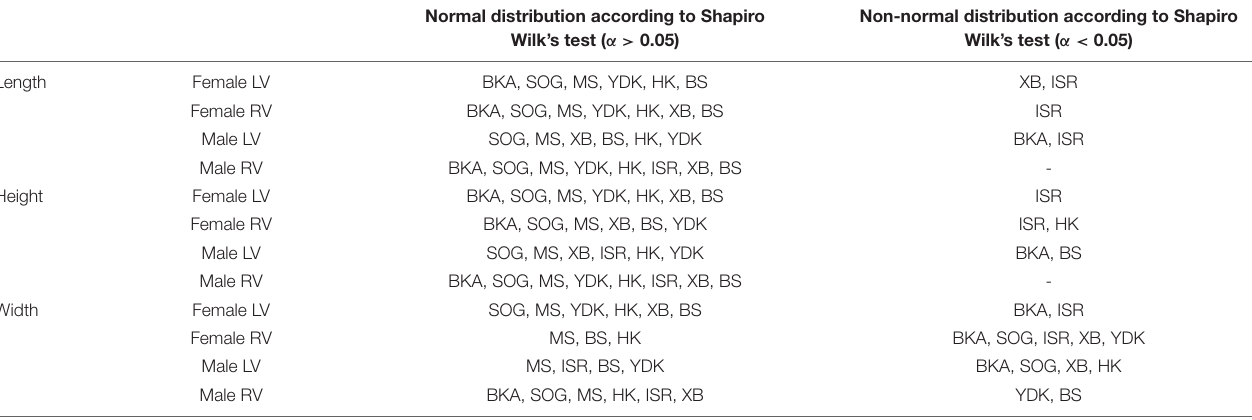
TABLE 2 | Overview of Shapiro Wilk’s tests for normal distribution separately for length, height, and width of female and male left (LV) and right (RV) valves. Normal distribution according to Shapiro Non-normal distribution according to Shapiro Wilk’s test ( α > 0.05) Wilk’s test ( α < 0.05)